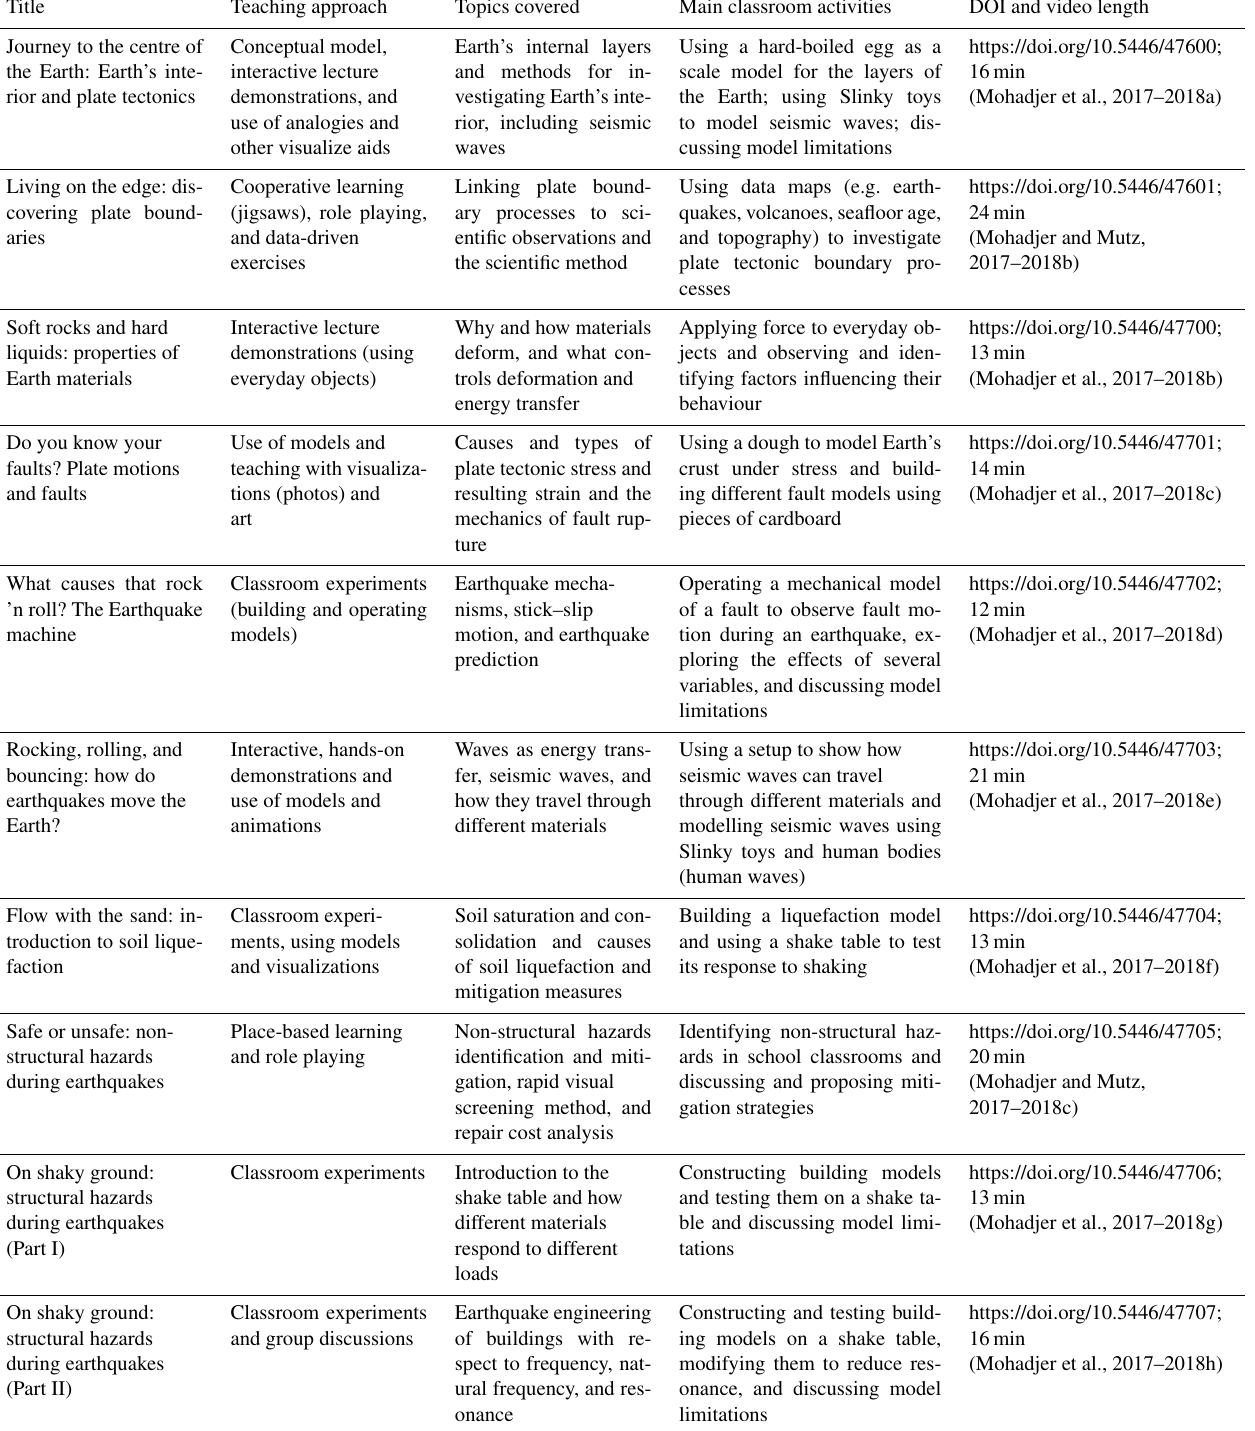
Table 1. Summary of the teaching approaches, topics covered, and classroom activities for each video, including the video duration and its digital object identifier